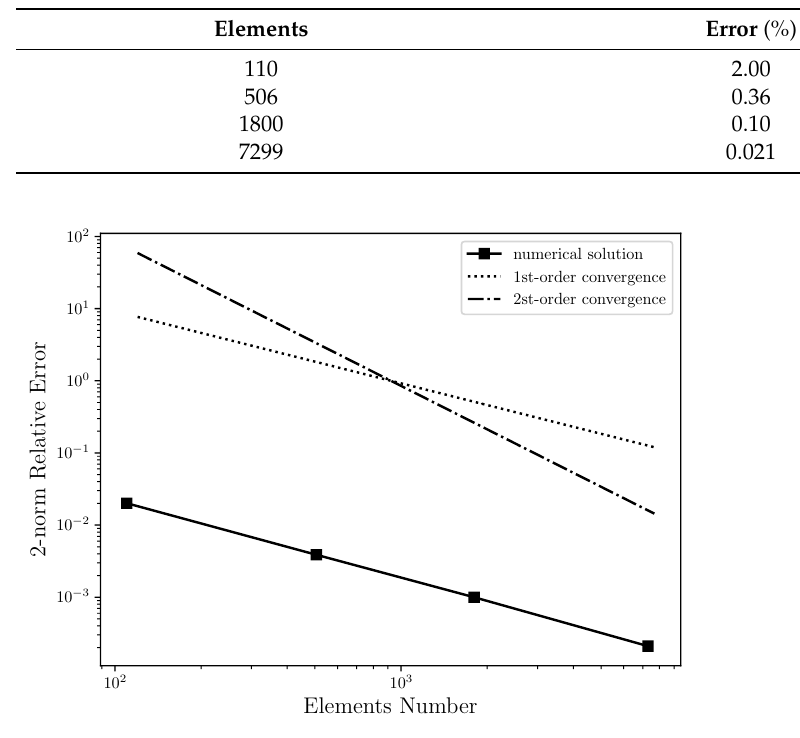
Figure 4. Convergence order for the horizontal velocity in log-log scale: It is estimated that the 2-norm relative error of numerical solution has first order convergence due to the vorticity boundary condition used in this work, which is first order